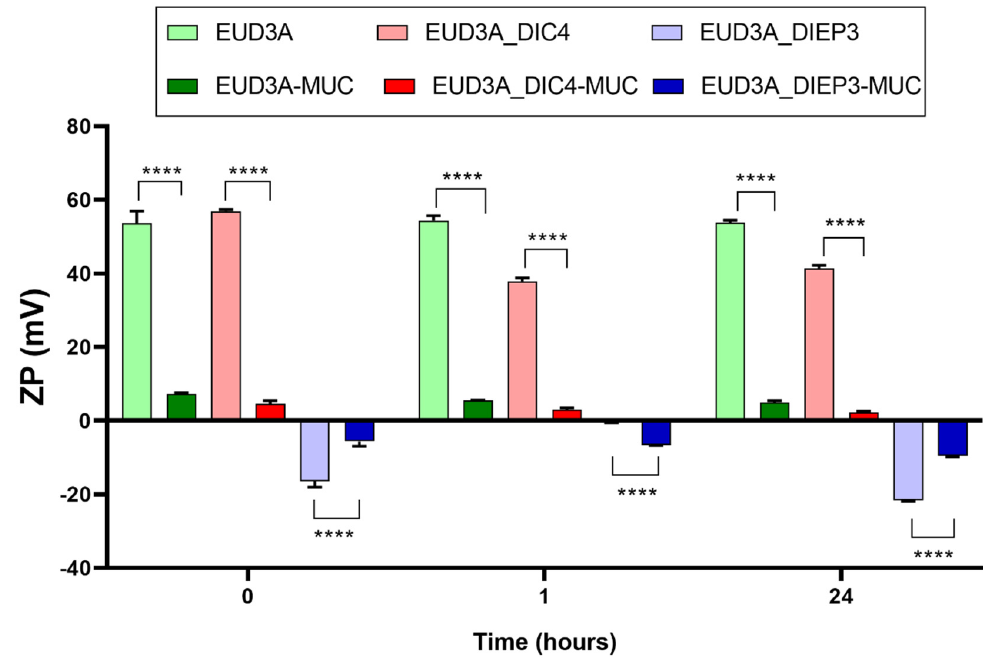
Figure 1. NPs zeta potential values (ZP) before (EUD3A, EUD3A_DIC4, EUD3A_DIEP3) and after (EUD3A_MUC; EUD3A_DIC4-MUC; EUD3A_DIEP3-MUC) 0, 1, and 24 h of incubation with mucin at 37 °C. Significance was set as **** p ≤ 0.0001.